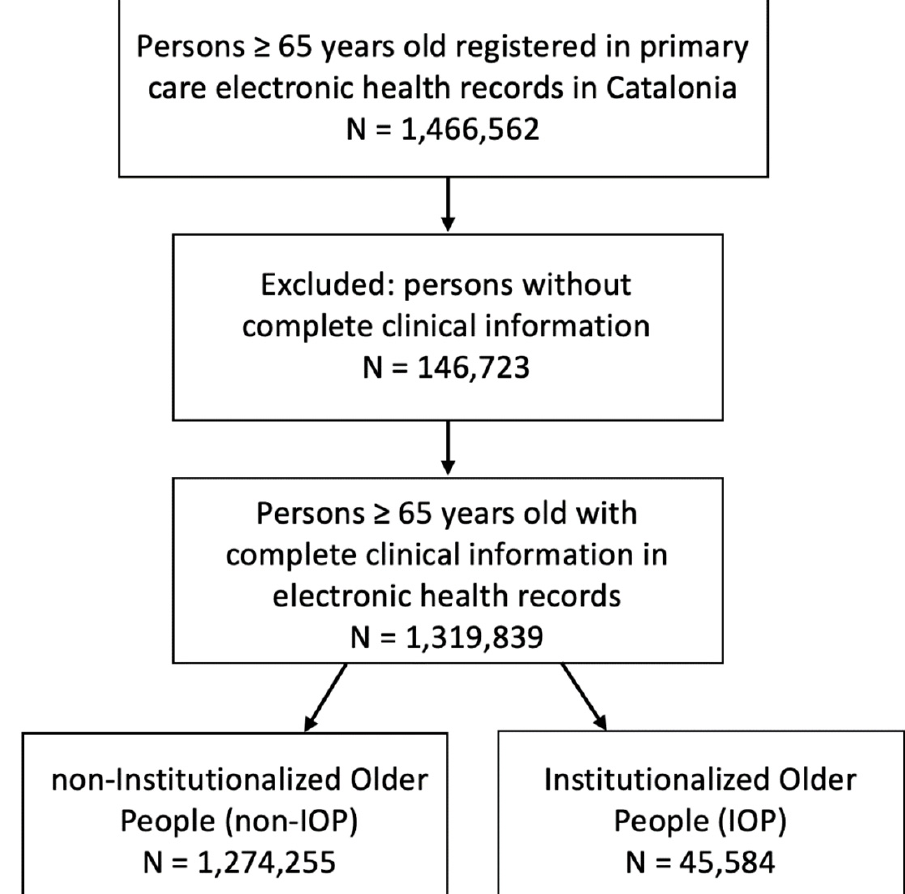
Figure 1. Flow chart with inclusion and exclusion criteria.